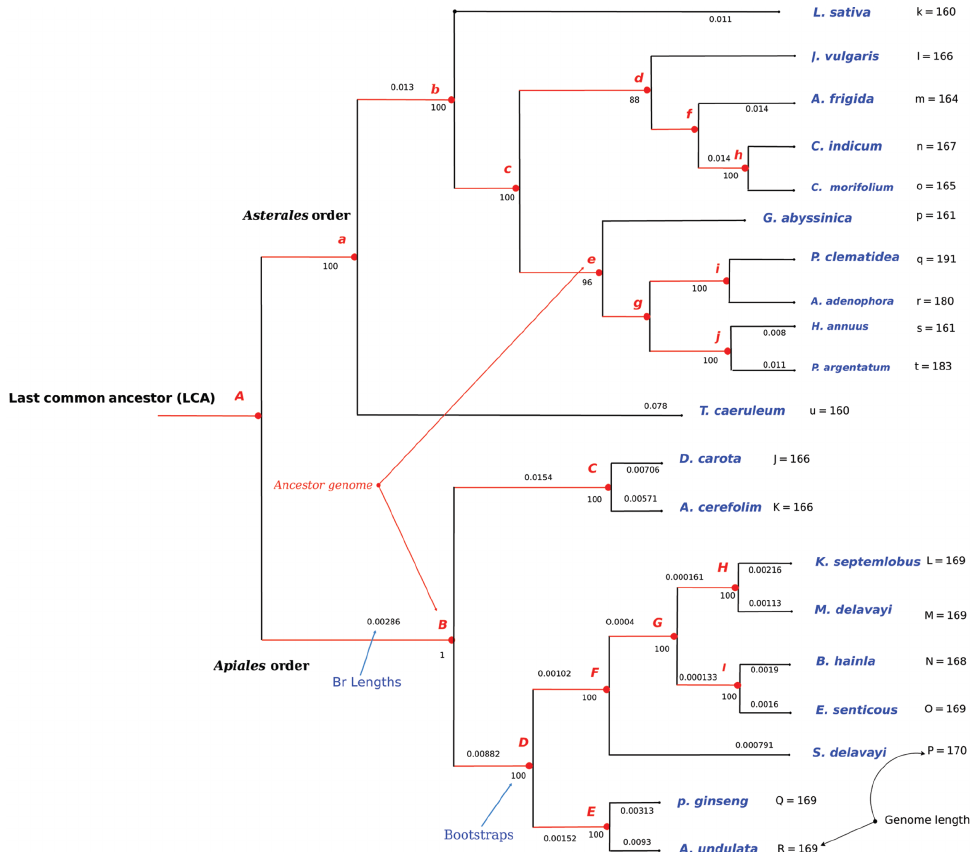
Figure 3: Names of the ancestors in the Apiales and Asterales phylogenetic tree, provided with supports and branch lengths: the numbers shown at each branch are bootstrap scores computed by RAxML [4], while branch lengths are in- dicated (cf. Br